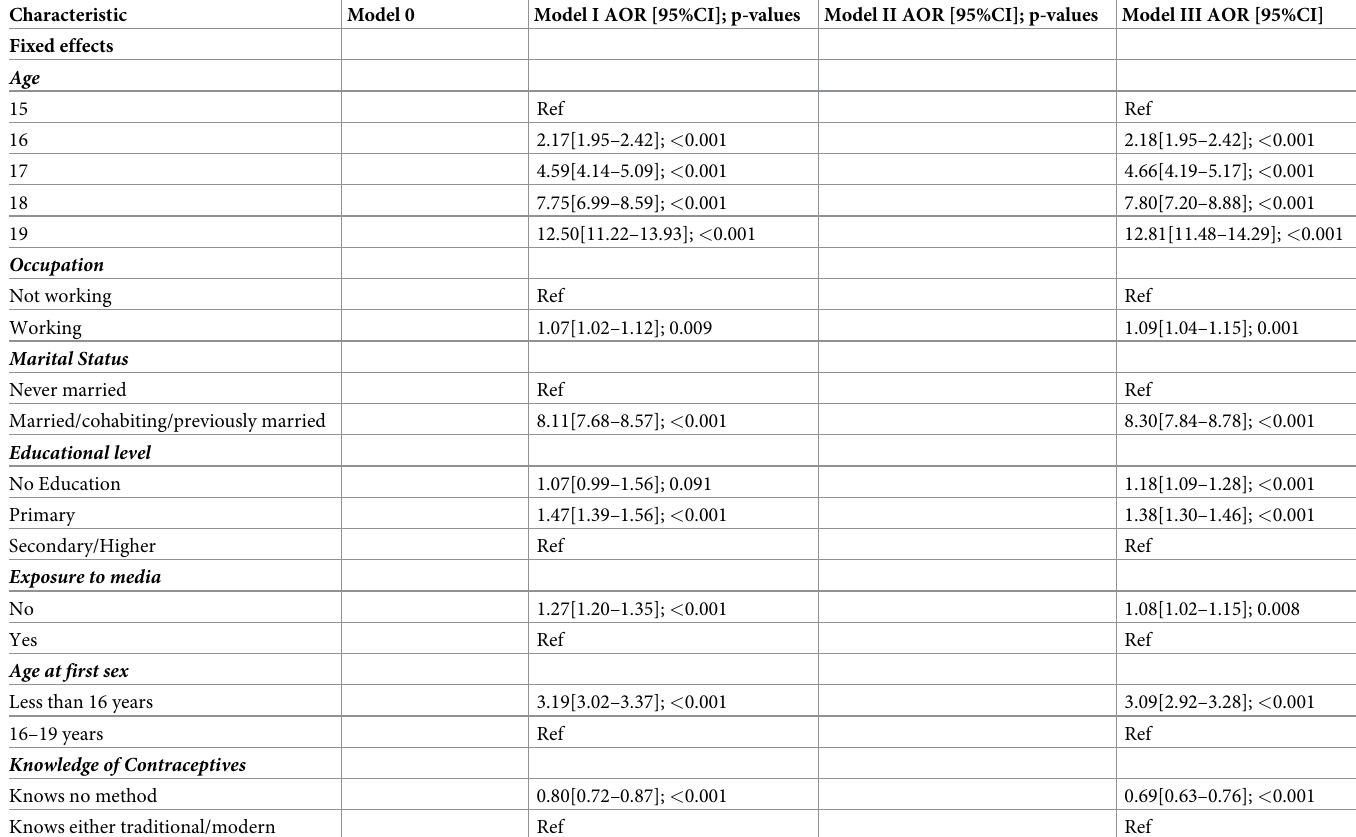
Table 3. Factors associated with first pregnancy in adolescents who had ever had sex in sub-Saharan Africa (DHS, 2010–2018). Characteristic Model